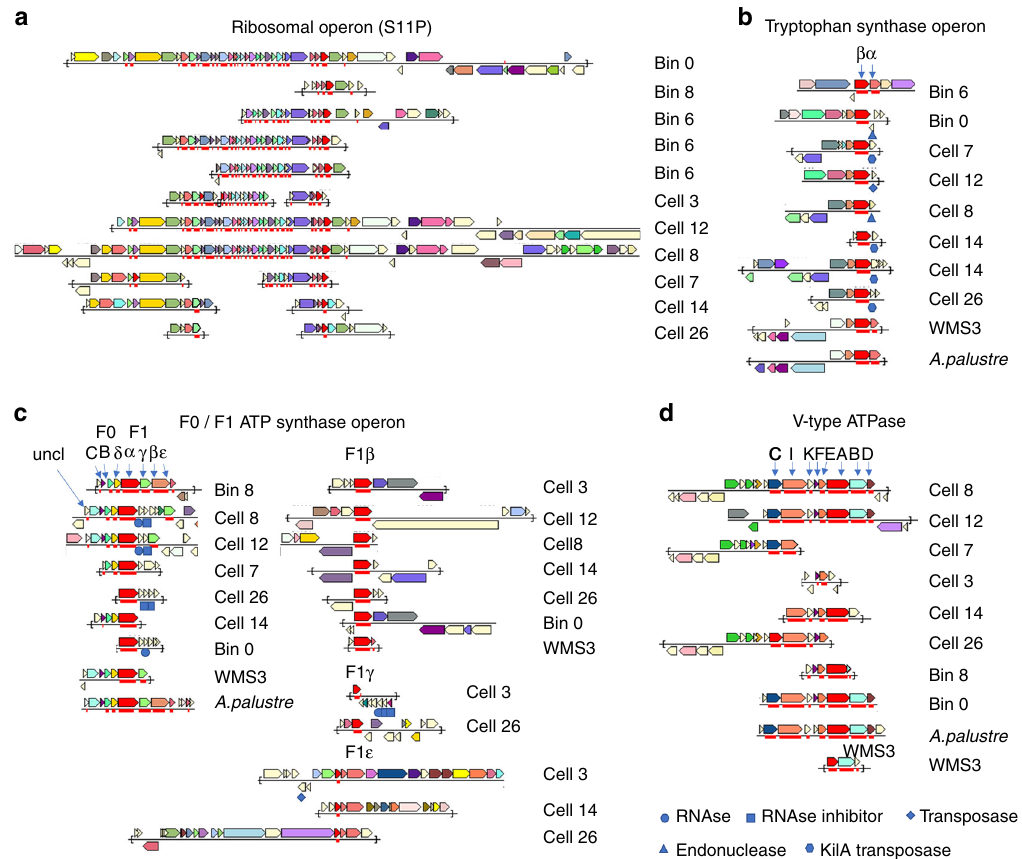
Fig. 6 Gene synteny of four bacterial operons. The operons are: ribosomal a , tryptophan synthase b , ATP synthase c , and V-type ATPase d . Additional individual genes from the tryptophan synthase and ATP synthase operons were identi fi ed and are not shown here. The data are available on IMG genome IDs 2642422595-9, 2710724216-17 and